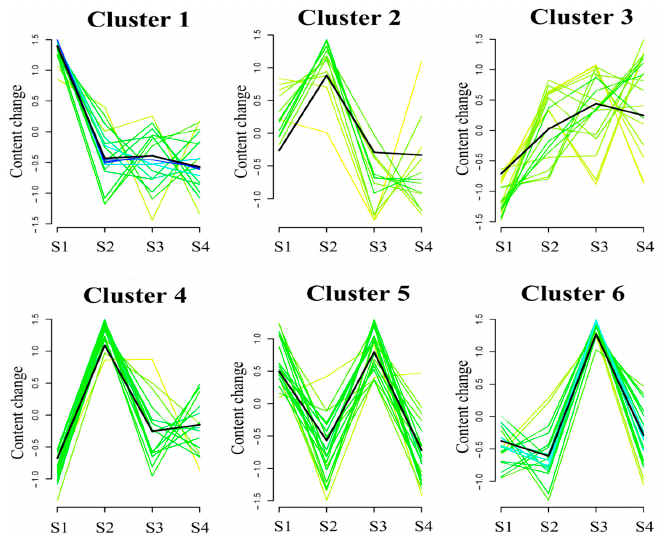
Figure 2. Cluster analysis of metebolites of seeds of C. vietnamensis in four maturation stages by using the Mfuzz package. Cluster 1: metabolites were mainly accumulated in S1; Clusters 2 and 4: